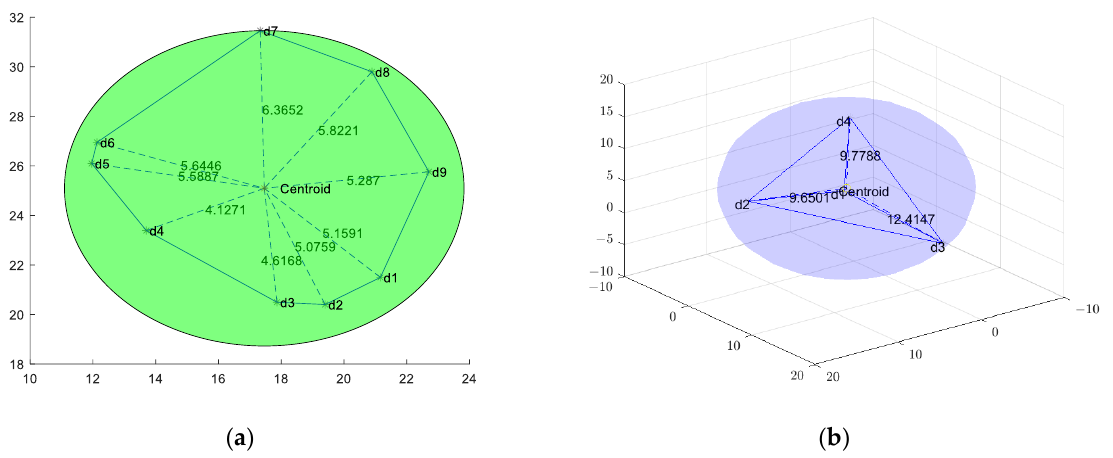
Figure 2. Schematic of Voronoi’s optimal sensing radius coverage: ( a ) Two-dimensional case; ( b ) Three-dimensional case.